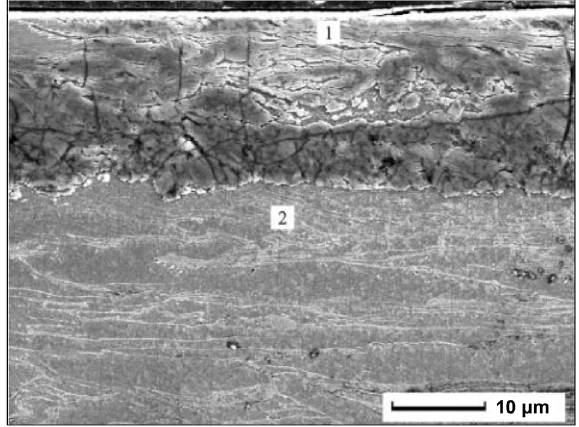
Fig. 9 Cross-sectional metallography image of worn-pinTi64 surface with TL, formed at an applied load = 200 N and temperature = 400 ° C ((1) TL and (2) substrate matrix, i.e., Ti64). Reproduced with permission from Ref. [113]. Copyright Taylor & Francis, 2012.